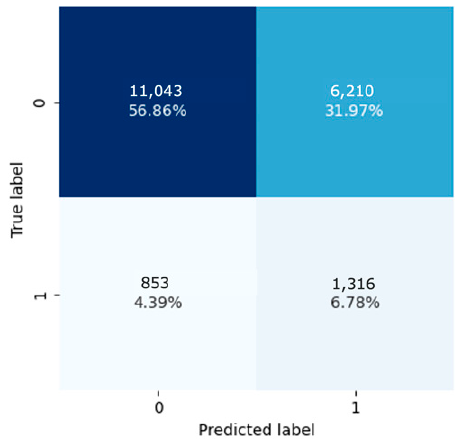
Figure 6. Confusion matrix for stacking model.